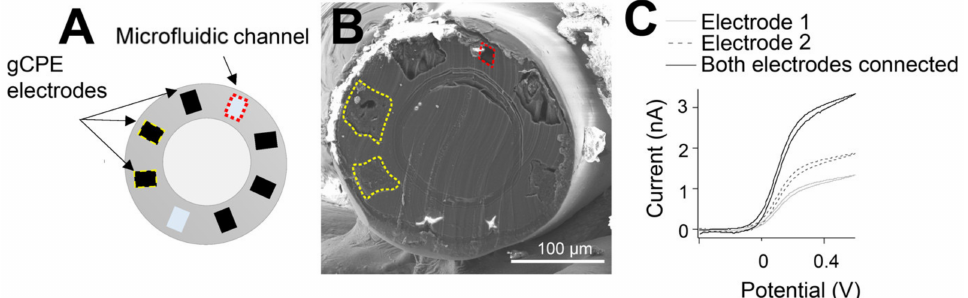
Figure 8. ( A ) Schematic drawing of the cross-section of the as-prepared fiber. Two of six graphite carbon paste electrodes and two microfluidic channels were highlighted in yellow and red boxes. ( B ) The razor blade-sliced fiber surface under Scanning Electron Microscopy image. ( C )